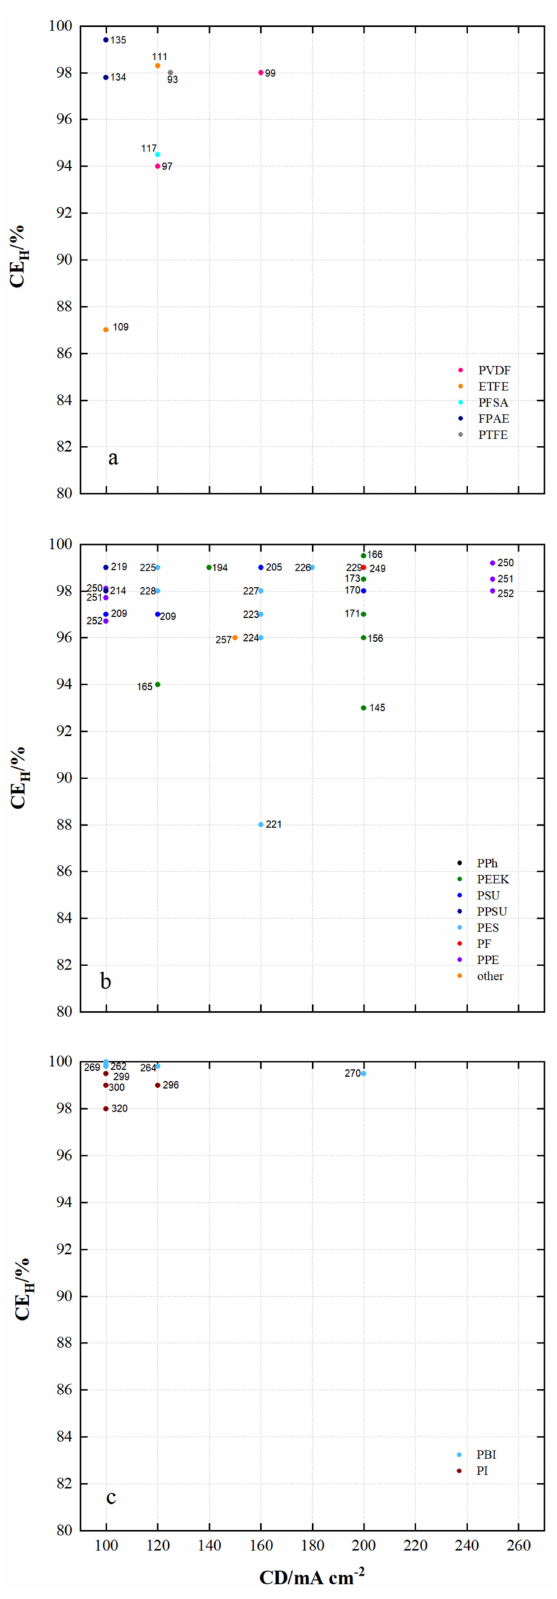
Figure 12. The coulombic efficiency of VRFB cells by using membrane samples at current densities ≥ 100 mA cm − 2 : ( a ) fluoro-carbons, ( b ) hydro-carbons and ( c ) N